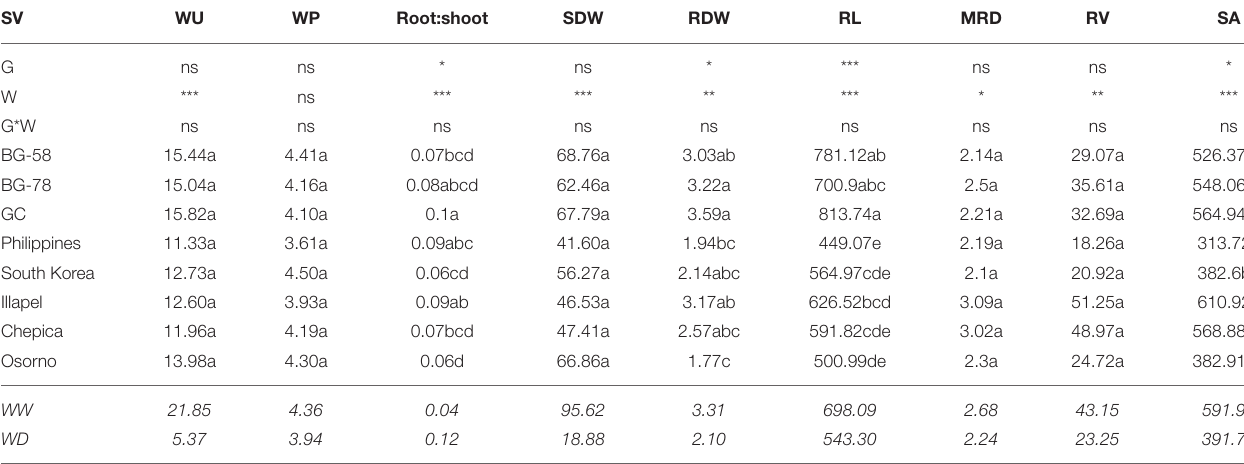
TABLE 1 | ANOVA results for the effect of water regime (W), genotype (G) and their interaction (G * W) on water consumption (WU), water productivity (WP), root and shoot biomass (RDW and SDW, respectively), and root traits (RL, Root length; MRD, Mean Root Diameter; RV, Root Volume; SA, Surface Area) evaluated in eight bottle gourd genotypes under well-watered (WW) and water-deficit (WD) conditions.